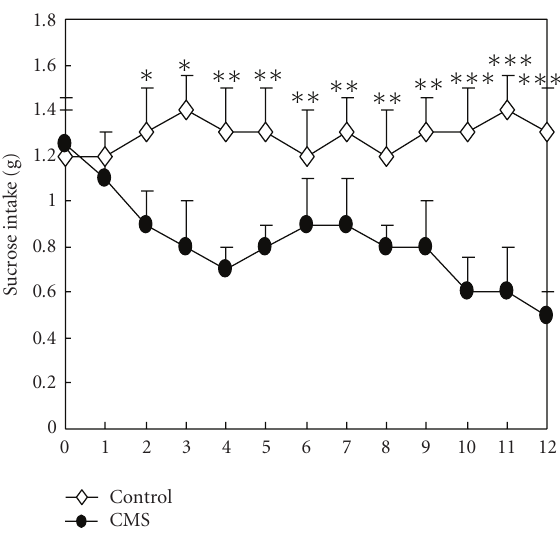
Figure 1: 1% sucrose solution preference in CMS and control groups ( n = 20 per group) following di ff erent weeks of CMS. Sucrose intake was significantly reduced in the CMS group com- pared with the corresponding control group. There was a significant stress × week interaction on sucrose intake ( n = 20, P < . 001 by ANOVA). An ANOVA performed on sucrose intake yielded a main e ff ect of group ( P < . 001). Values are means ± SEM. ∗ P < . 05, ∗∗ P < . 01, ∗∗∗ P < . 001 versus respective CMS value.